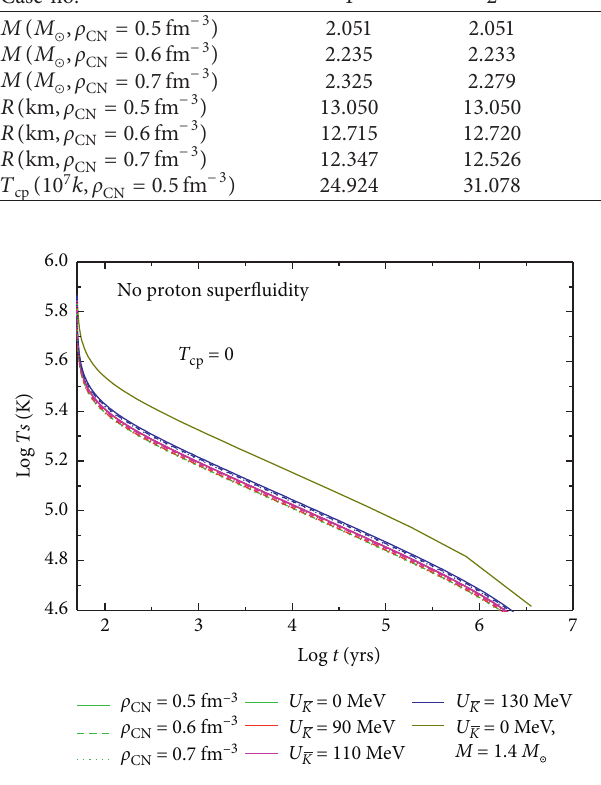
Figure 4: Theoretical cooling curves for the nonsuperfluid NS matter compared with the cooling of a nonsuperfluid 1.4 M � 0MeV. The initial time (t) � 50 years. Figure 5: Observational data of 7 pulsars J1357-6429, B1706-44, with U K